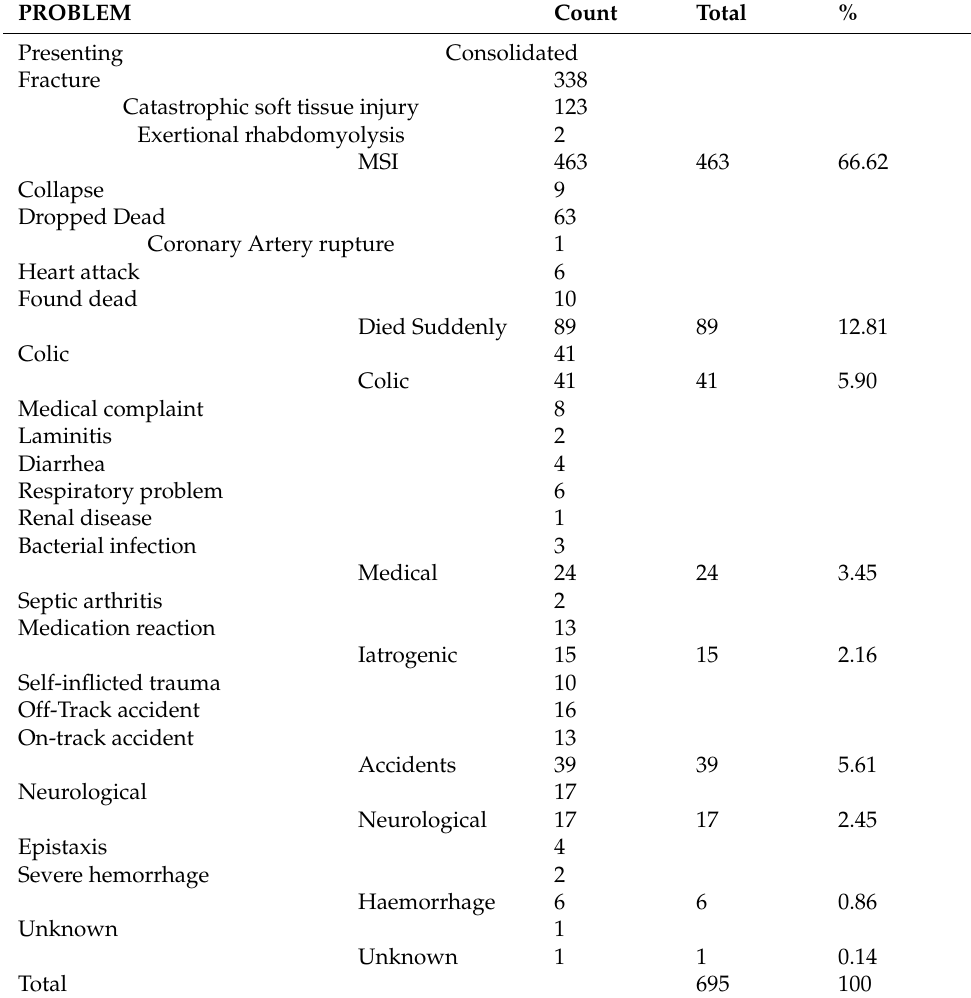
Table 2. Distribution of presenting complaints and results of consolidation for Ontario Thoroughbred horse fatalities,